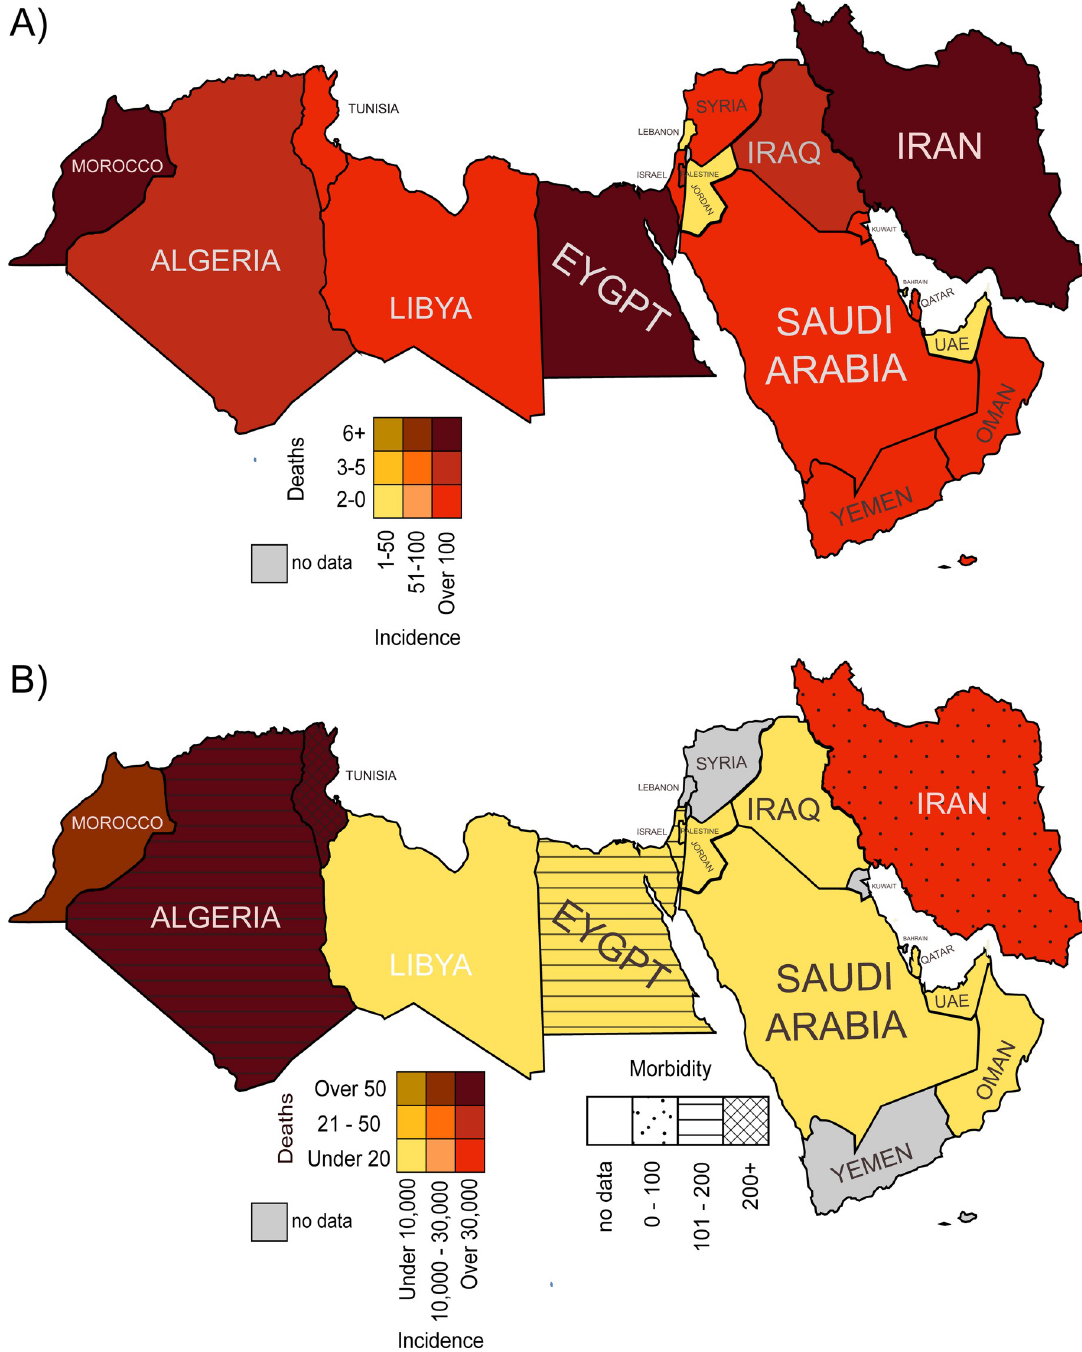
Fig 4. Country-specific overview of the epidemiology of snakebite (A) and scorpion stings (B) in the MENA region. The country- specific data were obtained from epidemiological literature covering the past 25 years (1995 to 2020). The data represent absolute numbers, and details can be found in S1 Table. MENA, Middle East and North